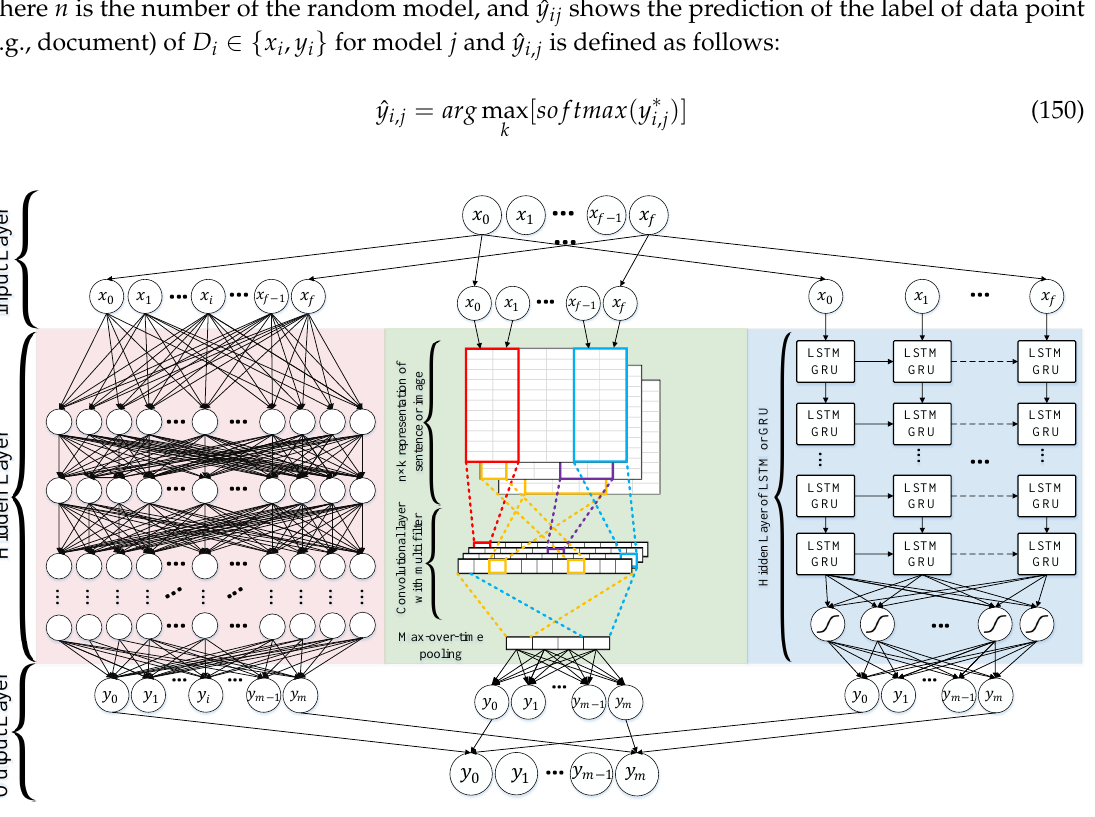
Figure 21. Random multimodel eeep learning (RDML) architecture for classification. RMDL includes 3 random models: A deep neural network (DNN) classifier ( left ), a deep CNN classifier ( middle ), and a deep recurrent neural network (RNN) classifier ( right ). Each unit could be a LSTM or